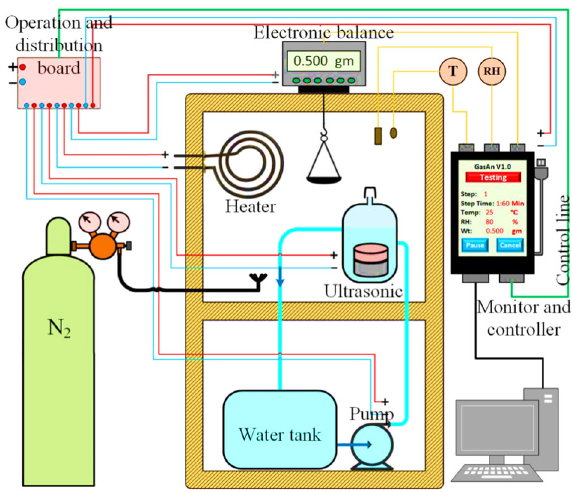
Fig. 9 Schematic of water adsorption apparatus. It was used to measure the adsorption isotherms and kinetics of the Max